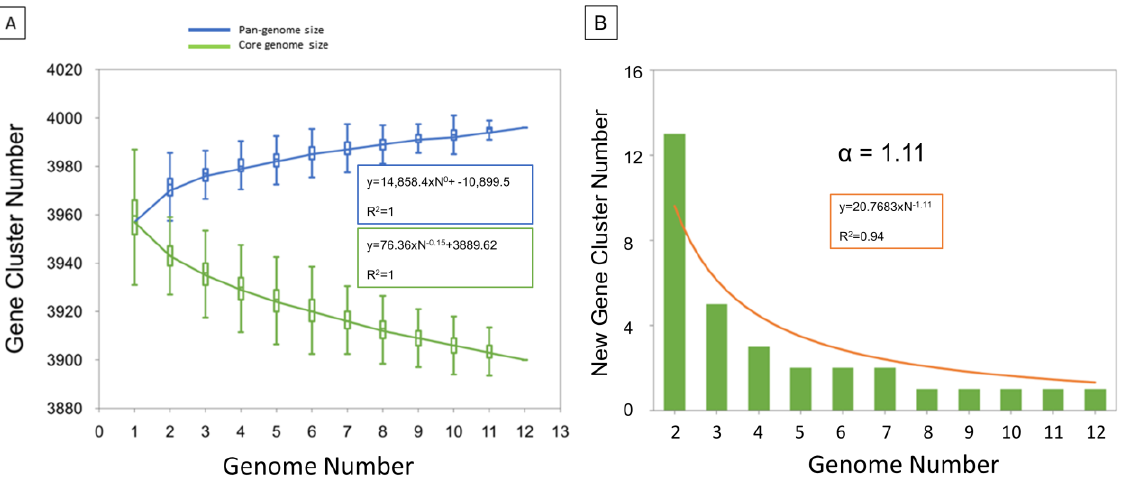
Figure 3. Pan-genome profile calculated with PanGP tool. ( A ) The figure shows two gene cluster accumulation curves for pangenome (blue) and core genome (green). ( B ) Evolution of new gene cluster numbers over genome number. The trend line (in orange) defines the curve equation and the alpha diversity.